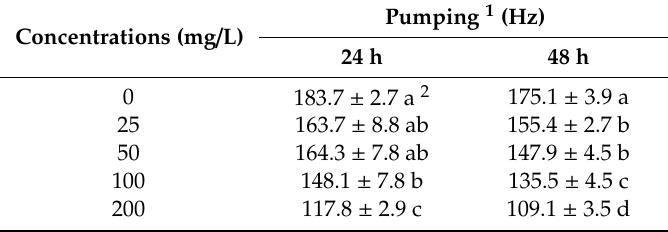
Table 2. E ff ect of FAc on the food pharyngeal pumping of C. elegans Table 2. Effect of FAc on the food pharyngeal pumping of C. elegans .